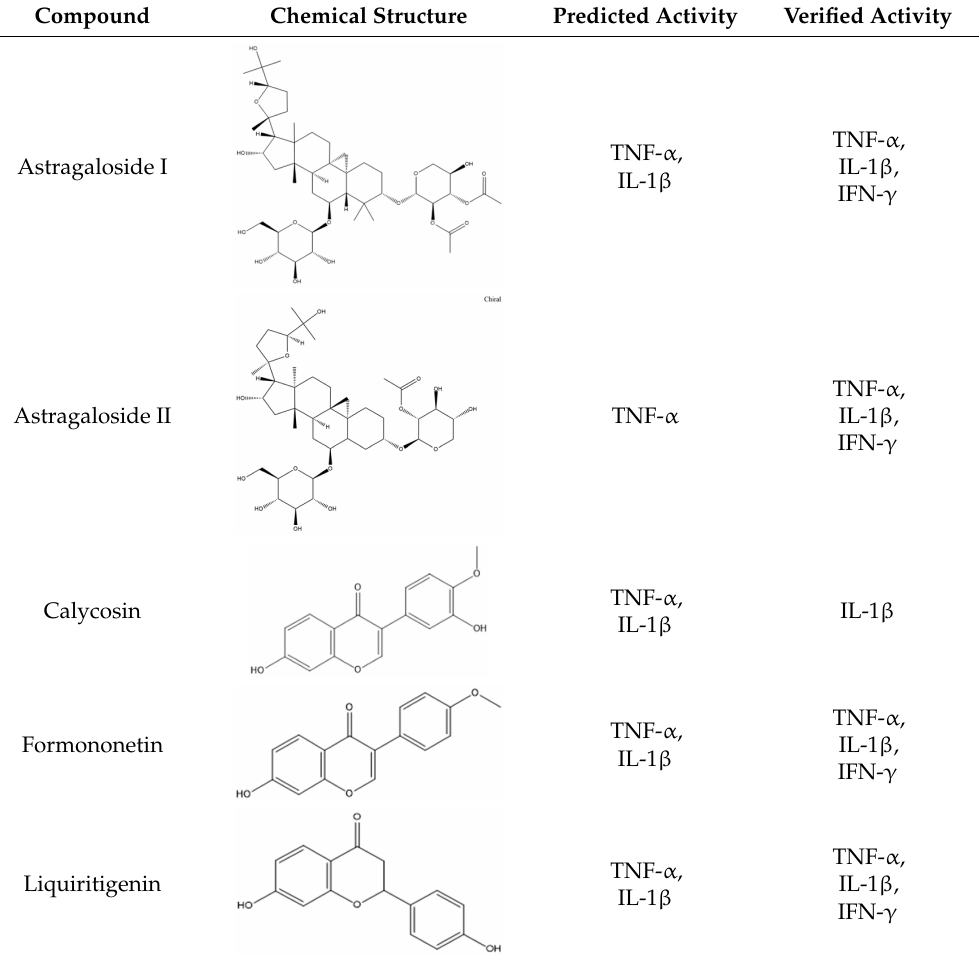
Figure A5. XVar Plots illustrating the levels of the compounds ( a ) liquiritigenin (257.08161_9.822) and isoliquiritigenin (257.08155_13.588) in Radix et rhizoma glycyrrhizae preparata (RRGP) extracts and in HJQZT extract, and ( b ) astragaloside I (1737.96629_18.398) and astragaloside II (1653.94391_15.879) in Radix Astragali (RA) and in HQJZT extracts. Table A5. Summary of the predicted and verified e ff ects of the tested pure hit compounds, at a screening concentration of 6.25 µ g /